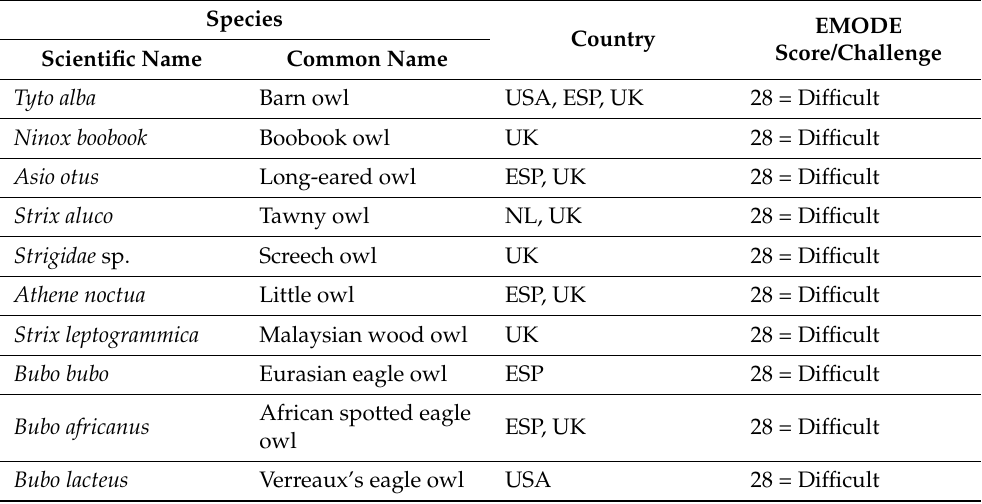
Table 7. Birds involved in handling and other practices at mobile zoos by species and country of where used, and their EMODE ‘suitability to keep’